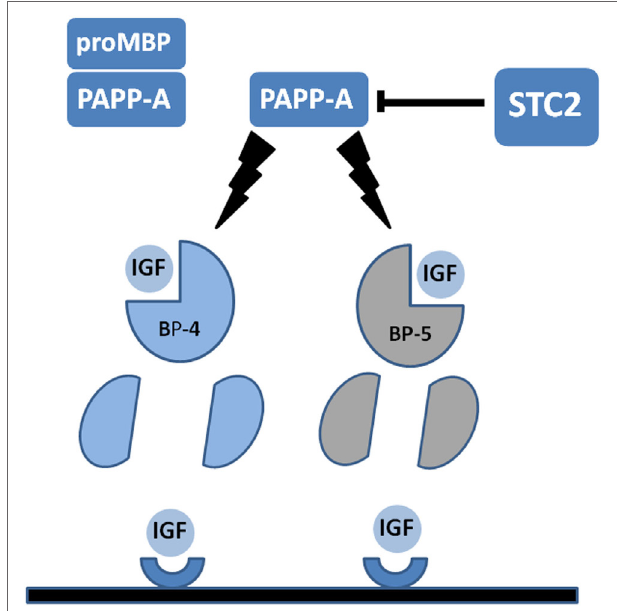
FiGURe 1 | Diagrammatic representation of pregnancy-associated plasma protein-A (PAPP-A) activity in the insulin-like growth factor (IGF) axis. PAPP-A is present in serum and some other biological fluids covalently complexed with the pro-form of eosinophil major basic protein (proMBP). In this form PAPP-A is inactive. Uncomplexed PAPP-A acts to cleave IGF-binding protein-4 (IGFBP-4) and IGFBP-5 into fragments with reduced IGF-binding affinity. IGFBP-4 but not IGFBP-5 requires binding of IGF for PAPP-A cleavage. Proteolysis of IGFBP substrates releases IGFs to allow interaction with cognate cell surface receptors. Recently, discovered stanniocalcins (STC1 and STC2) act to inhibit PAPP-A activity. STC2 is shown, and this inhibitor forms a covalent bond with PAPP-A to inhibit the proteolytic activity. See the text for further